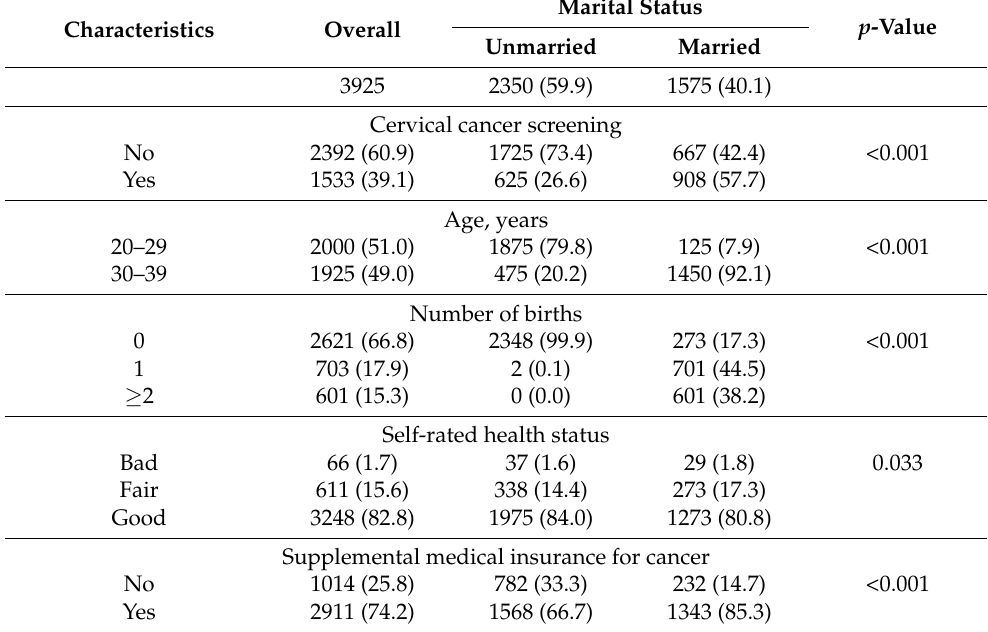
Table 1. Participants’